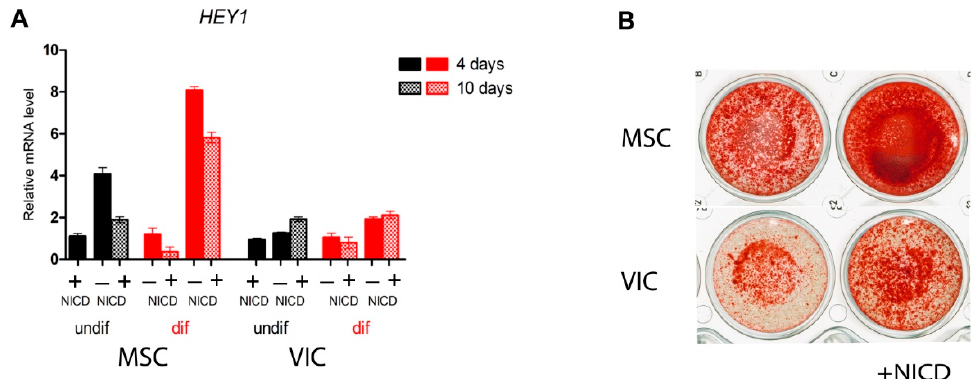
Figure 1. Mesenchymal stem cells (MSCs) of adipose tissue are more sensitive to the Notch-dependent induction of osteogenic differentiation in comparison with aortic valve interstitial cells (VICs). The cells were transduced with the lentiviral Notch intracellular domain (NICD) and osteogenic differentiation was induced. The expression of Notch target HEY1 was analyzed by qPCR after either 4 or 10 days of differentiation ( A ) and osteogenic differentiation was analyzed by alizarin staining ( B ).